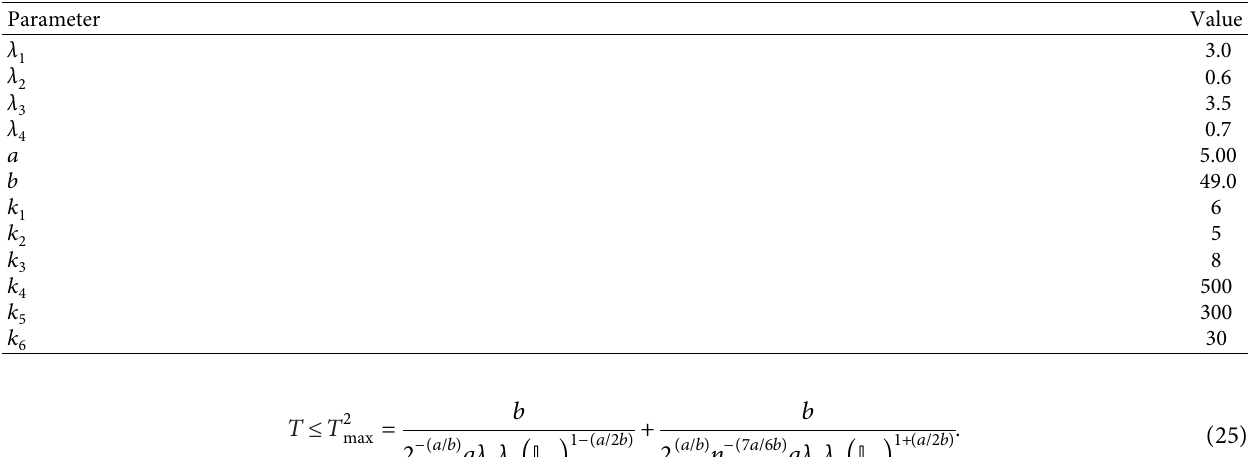
Figure 2: Communication topology and the desired formation shape. Table 1: Parameters of control